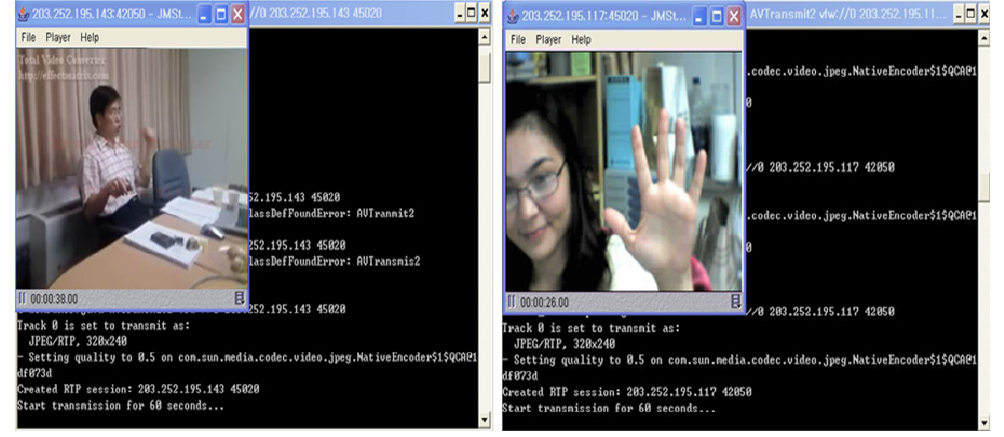
Figure 9. Fusion media being transferred to multiple